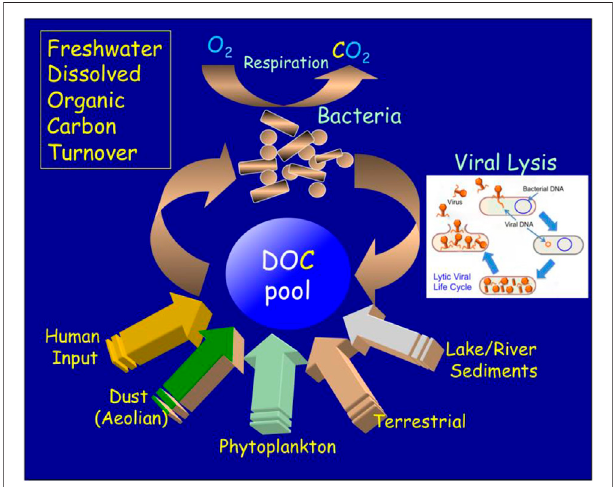
FIGURE 9 | Model of how bacteria use carbon from the DOC pool to respire the sources of DOC to emit CO 2 from freshwater (DOC) in the pool remainsconstant — input=output.Virallysisofthebacteriafacilitatesbacterial respiration by recycling organic carbon through the DOC pool.